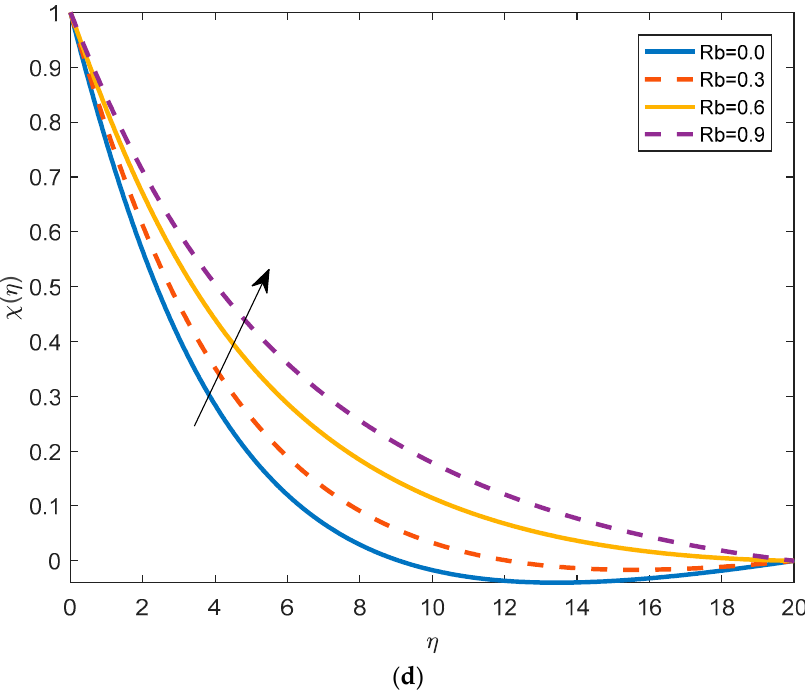
Figure 6. ( a ): Velocity distribution for various Rb when Nt = 0.1, Nb = 2.0, M = 0.1, Pr = 1.5, W e = 0.2, λ = 0.2, Sc = 0.2, Sc n = 0.2, Pe = 1.0, K p = 0.5 at α = π /6. ( b ): Temperature distribution for various Rb when Nt = 0.1, Nb = 2.0, M = 0.1, Pr =1.5, W e = 0.2, λ = 0.2, Sc = 0.2, Sc n = 0.2, Pe = 1.0, K p = 0.5 at α = π /6. ( c ): Concentration distribution for various Rb when Nt = 0.1, Nb = 2.0, M = 0.1, Pr = 1.5, W e = 0.2, λ = 0.2, Sc = 0.2, Sc n = 0.2, Pe = 1.0, K P = 0.5 at α = π /6. ( d ): Density of motile micro-organisms for various Rb when N t = 0.1, N b = 2.0, M = 0.1, Pr =1.5, W e = 0.2, λ = 0.2, Sc = 0.2, Sc n = 0.2, Pe = 1.0, K p = 0.5 at α = π /6.